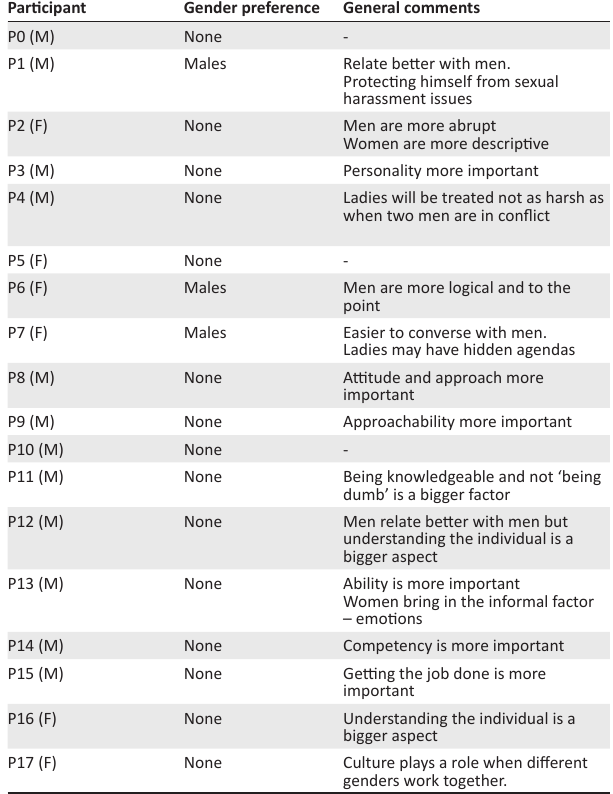
TABLE 3: Findings in terms of